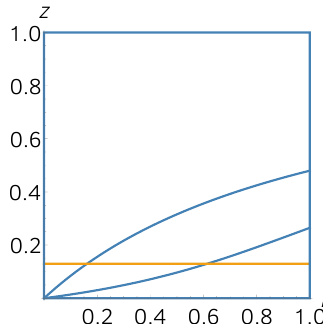
Figure 3 . The physical region in the l; z variables for (cid:12)xed Higgs mass ( x 2 = 13 = 25) and unit propagators mass (see text). The lines represent the singular points of the di(cid:11)erential equations. The orange line corresponds to the physical threshold x 1 = 4.